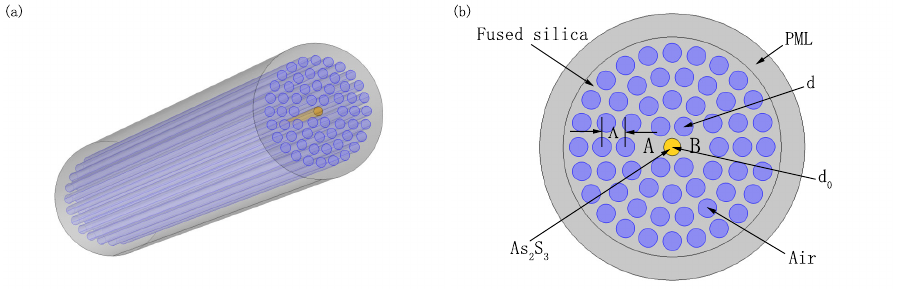
Figure 1. The designed circular PCF polarization beam splitter structure diagram, ( a ) three- dimensional structure, and ( b ) two-dimensional end